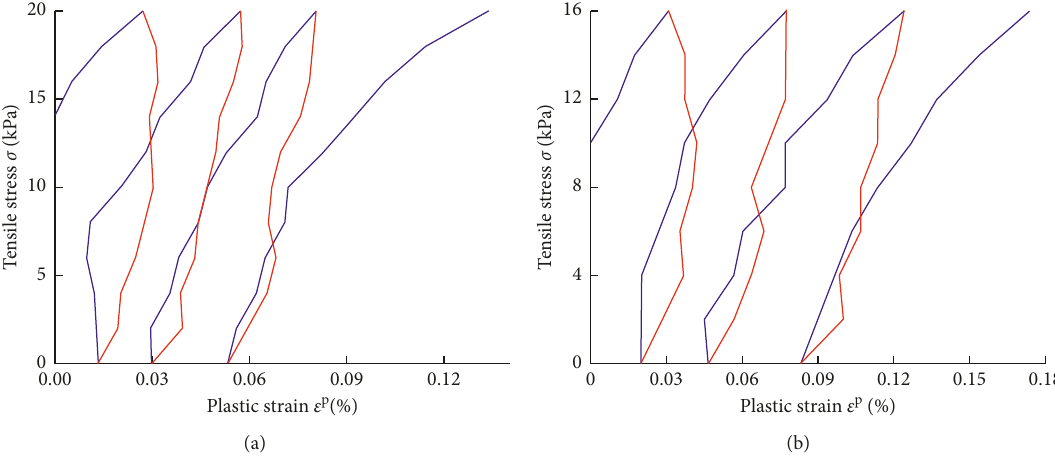
Figure 11: Stress-plastic strain curves of the cyclic tensile tests for load pattern I: (a) w � 16%; (b) w �